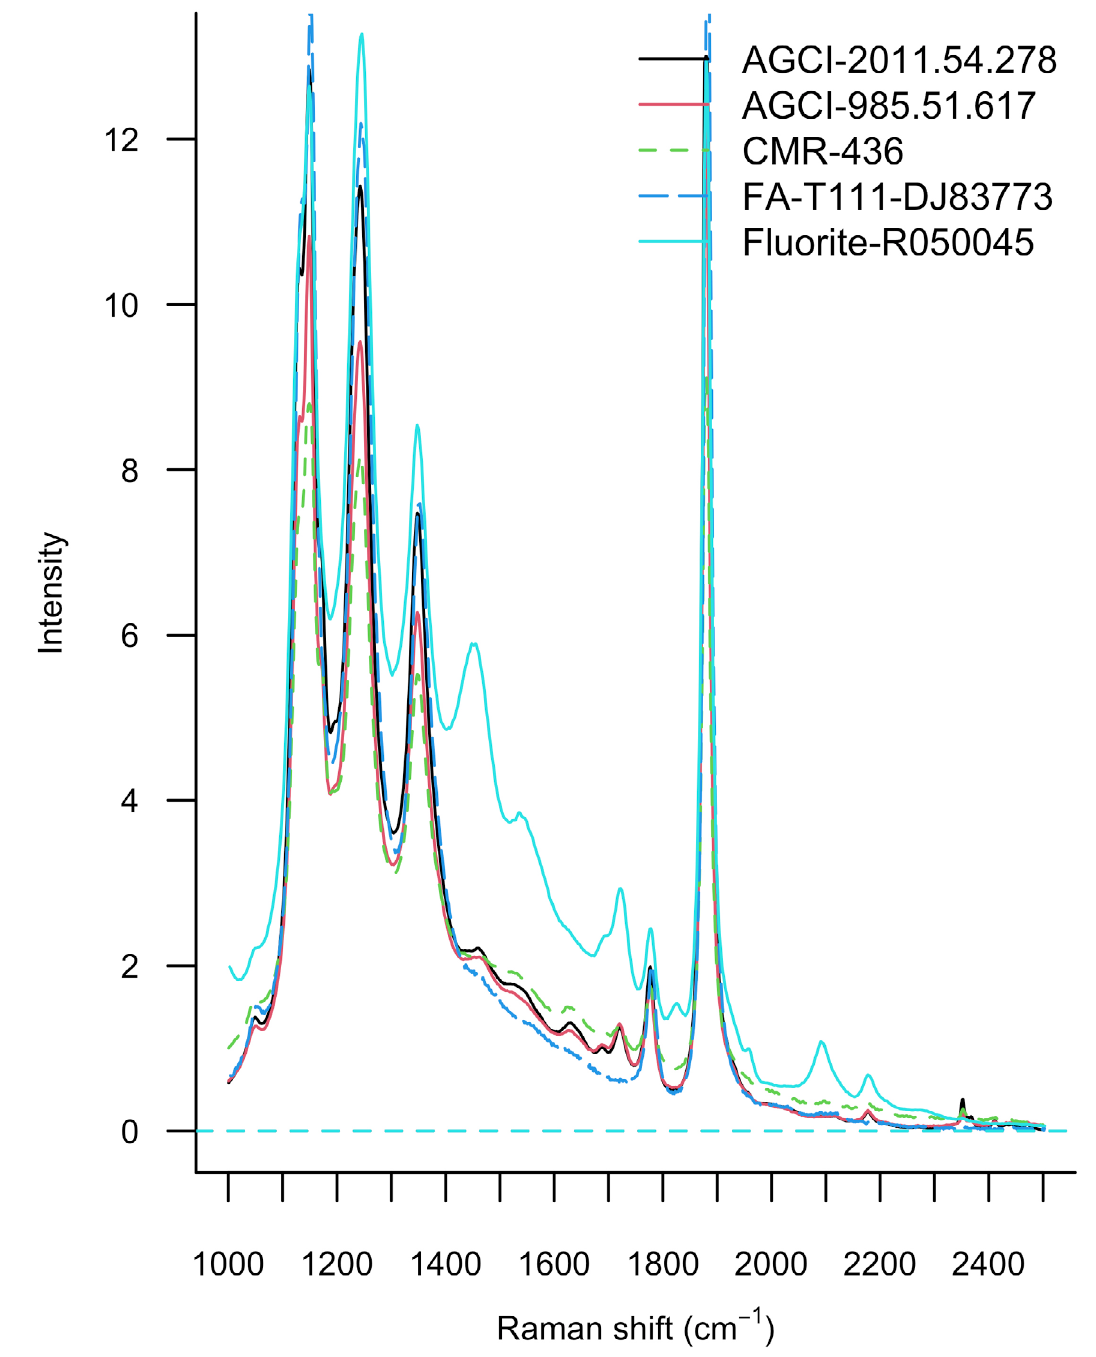
Figure 4. Raman spectra in the frequency-shift region between 1000 and 2500 cm -1 showing the typical fluorite PL